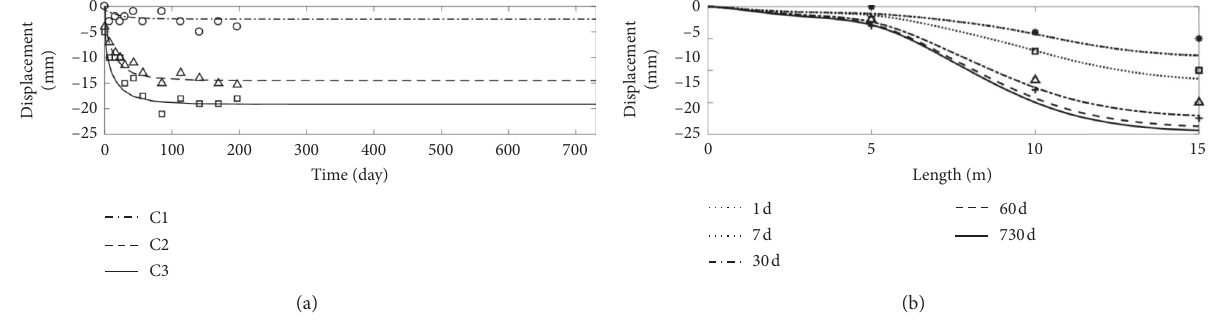
Figure 6: Comparison of settlement simulation results and field